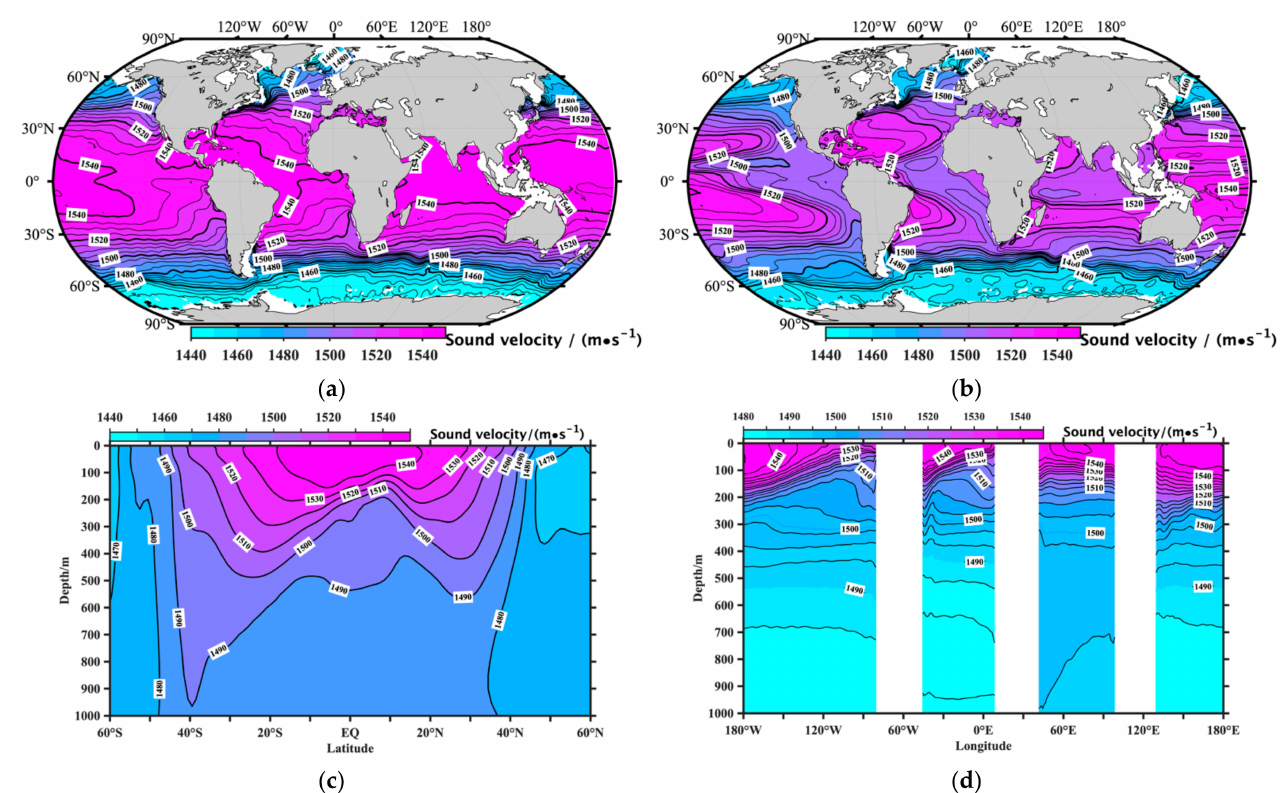
Figure 12. Annual characteristics of sound velocity ( a ) on the sea surface, ( b ) at a depth of 150 m, ( c ) along the 180 ◦ E section, and ( d ) 0.5 ◦ N across the global